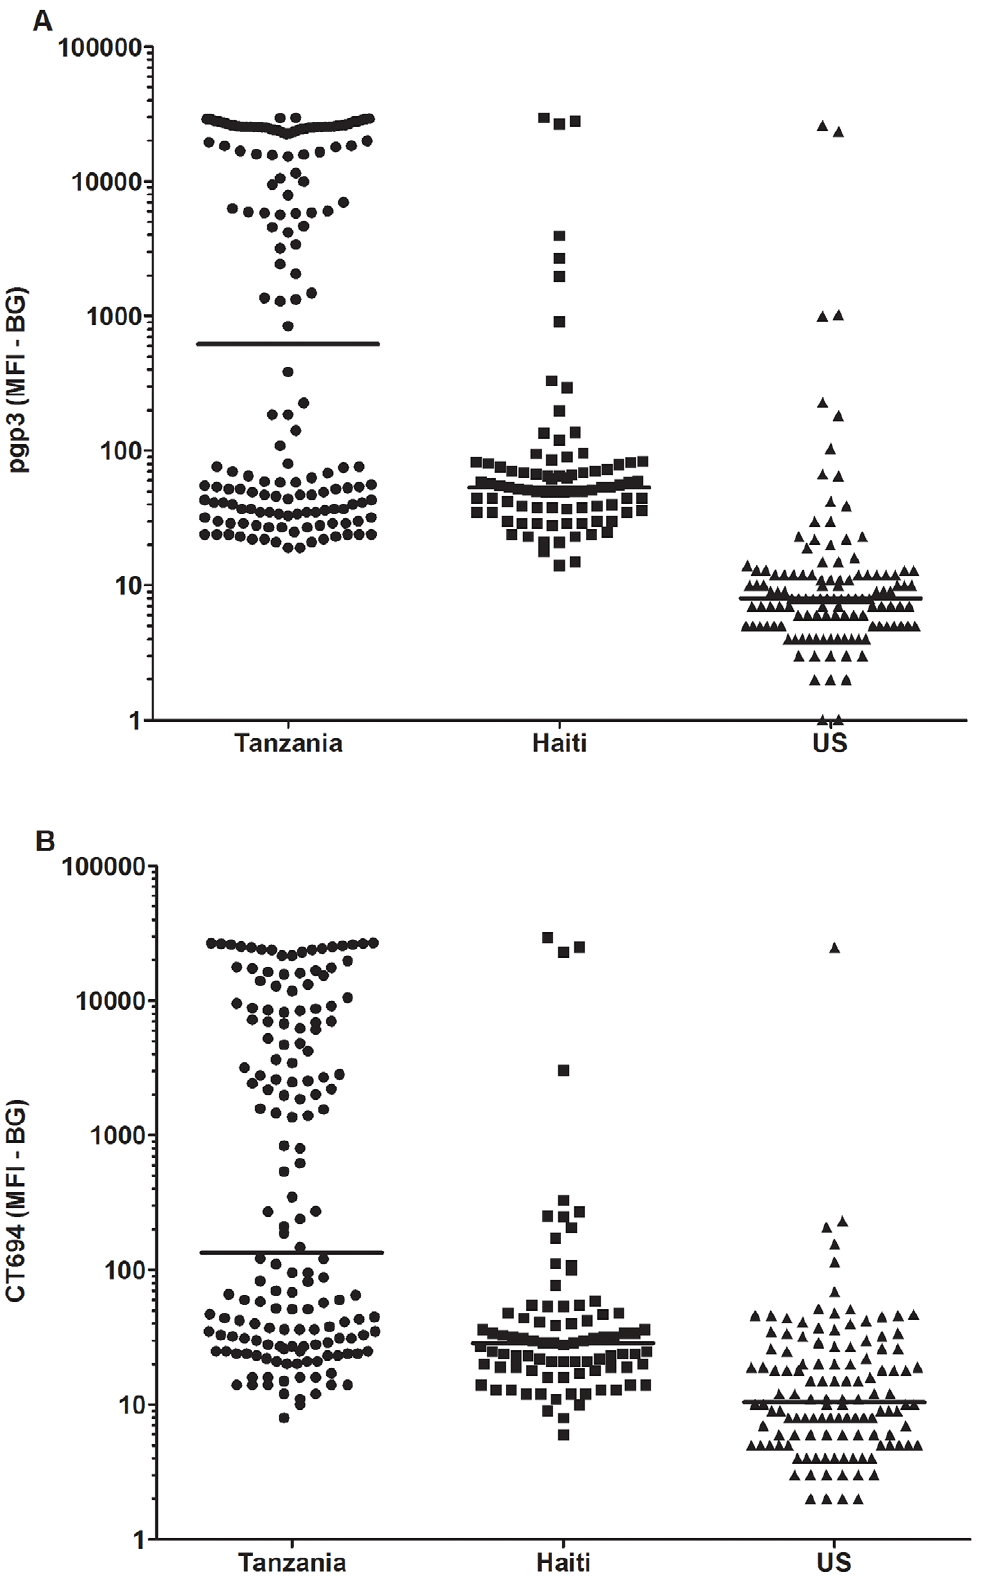
Figure 1. Antibody response to pgp3 and CT694 by country. Median responses are shown in median fluorescence intensity minus background (MFI-BG) by country for (A) pgp3 and (B) CT694. Sera from Haitian children (n=86) and from United States children (n=122) were used.